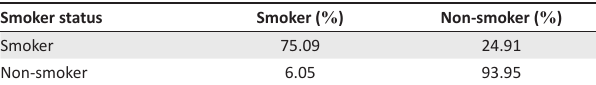
TABLE 5: Transition dynamics for smoker status.